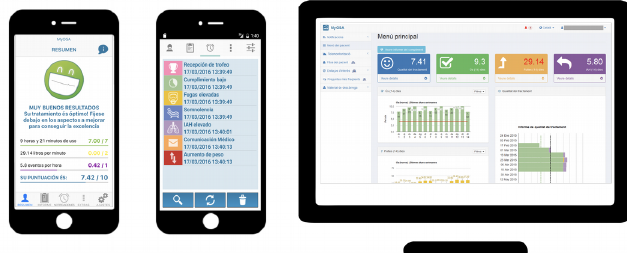
Figure 2. Screenshots of the myOSA system. On the left an example of recommendation to the patient through the app; in the center, the list of information given to a patient; on the right the main board in the web application for follow up by the lung